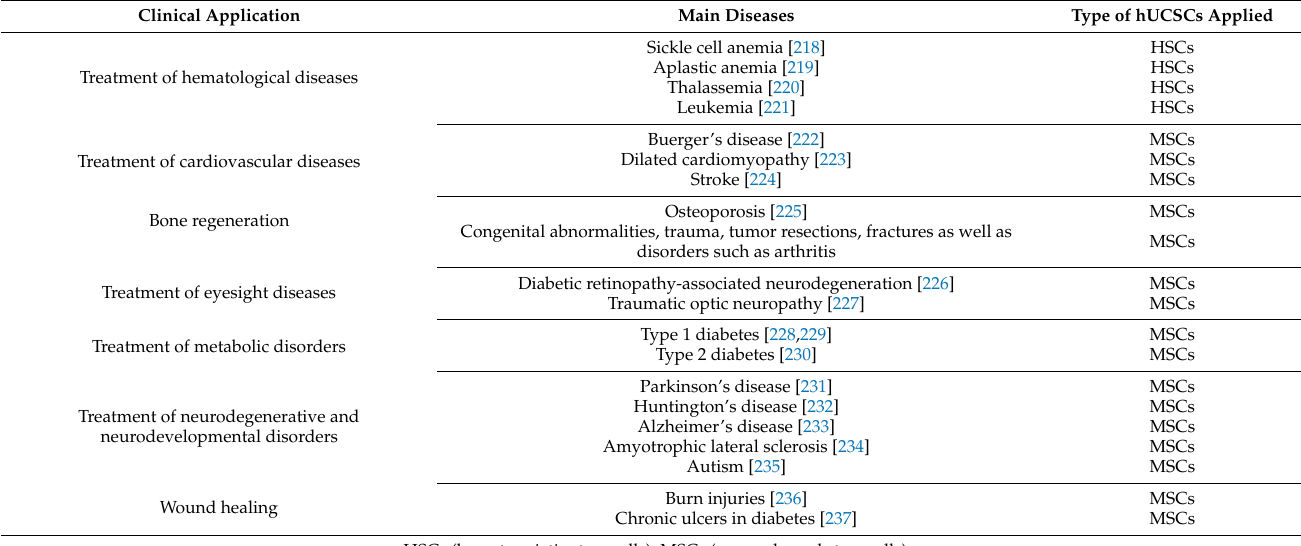
Table 2. Clinical applications of